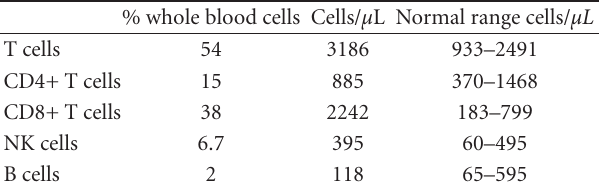
Figure 1. Normal levels of CD4+ T cells and B cells were also observed (Table 1). The patient is currently asymptomatic and without treatment, with few nontender and discrete cervical lymph